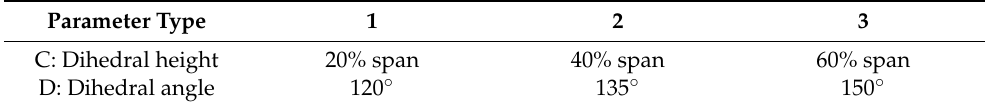
Table 2. Modeling scheme for blade dihedral.